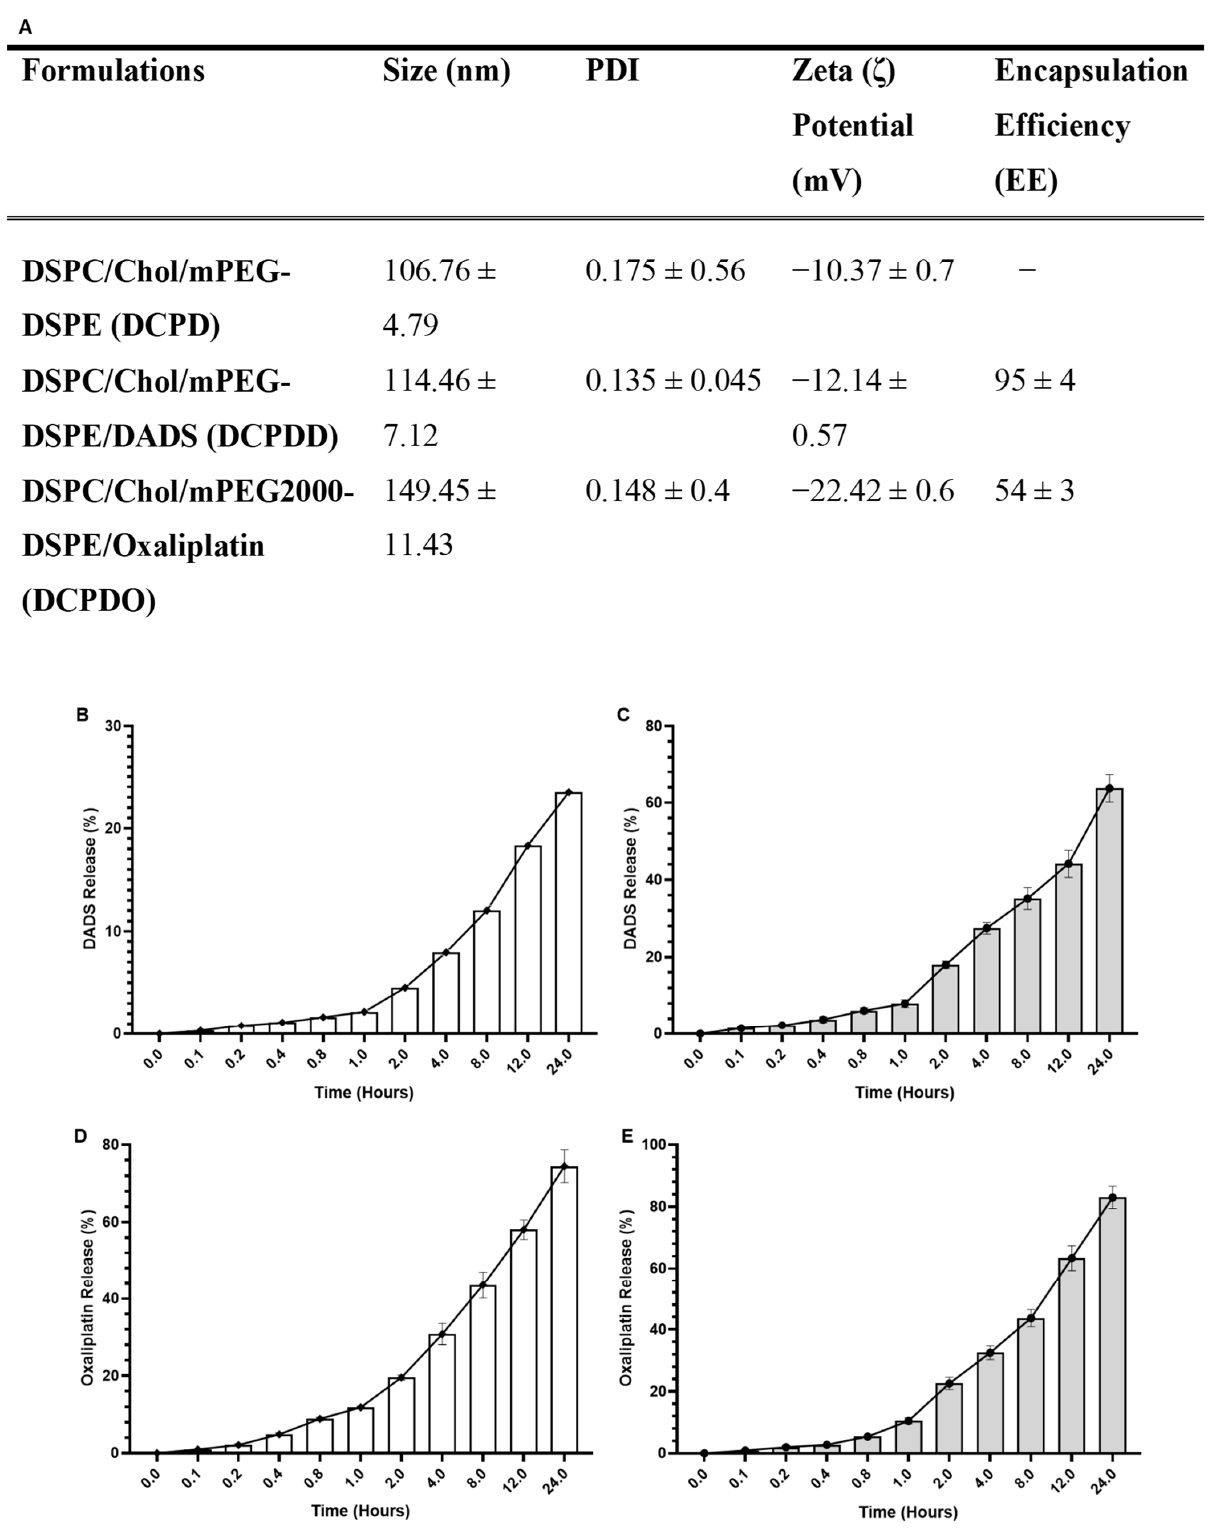
Figure 4. Characterization and in vitro stability and release kinetics of DCPDD and DCPDO: ( A ) size, PDI, zeta potential and entrapment efficiencies; ( B ) stability of DCPDD in PBS; ( C ) release kinetics of DCPDD from the liposomes into the serum; ( D ) stability of DCPDO in PBS; ( E ) release kinetics of DCPDO from the liposomes into the serum The values are expressed as mean ± SE of three independent